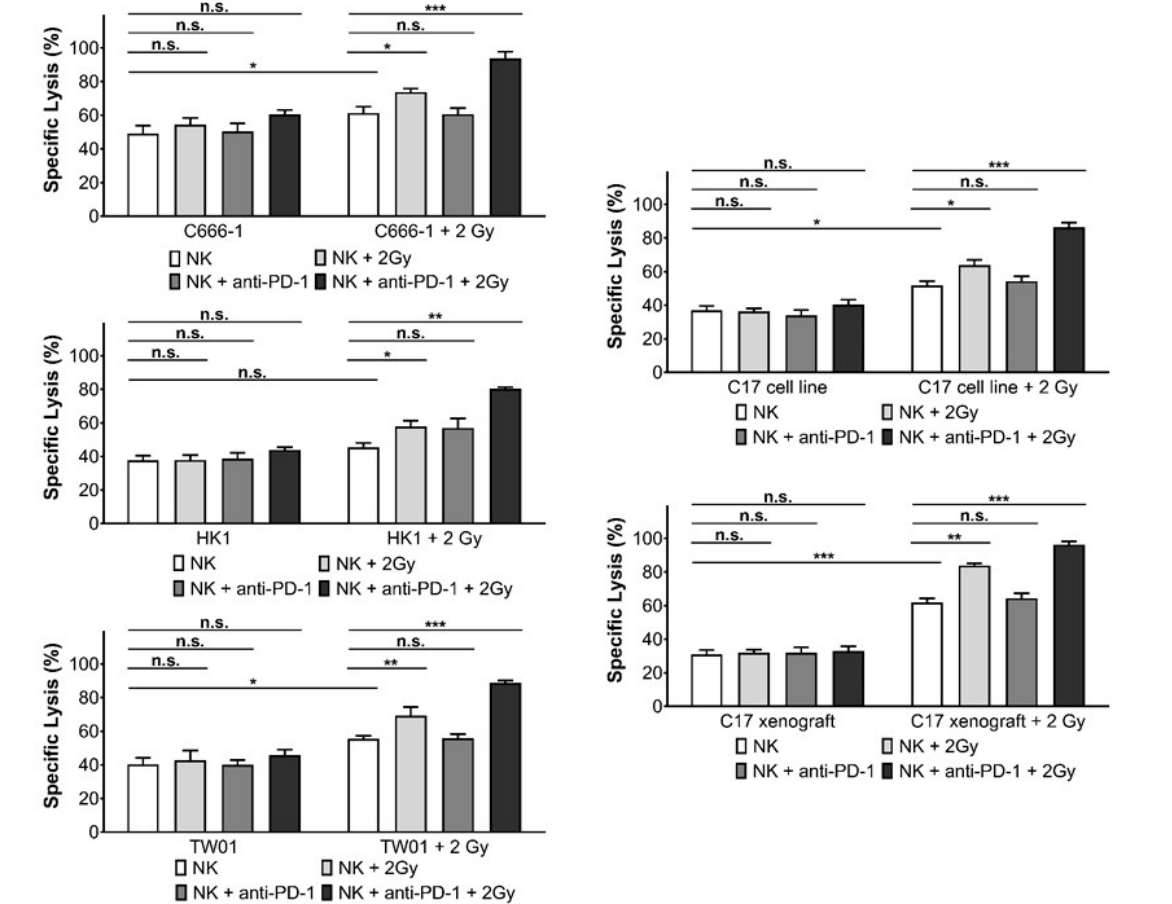
Figure 5. Inhibition of PD-1 increases killing of NPC cells by NK after radiation. NPC and NK cells were irradiated with 2 Gy. 24 h later, target cells were labeled with calcein, plated in a 96-well plate and incubated with NK cells for 4 h at an E:T ratio of 6:1. Lysis of target cells was determined by measurement of calcein in collected supernatants by an ELISA reader. Data are presented as means ± S.E.M. Asterisks indicate statistically significant differences between all cell lines in one ratio-group (two-way ANOVA; * p < 0.05; ** p < 0.01; *** p < 0.001, n.s.: not significant).